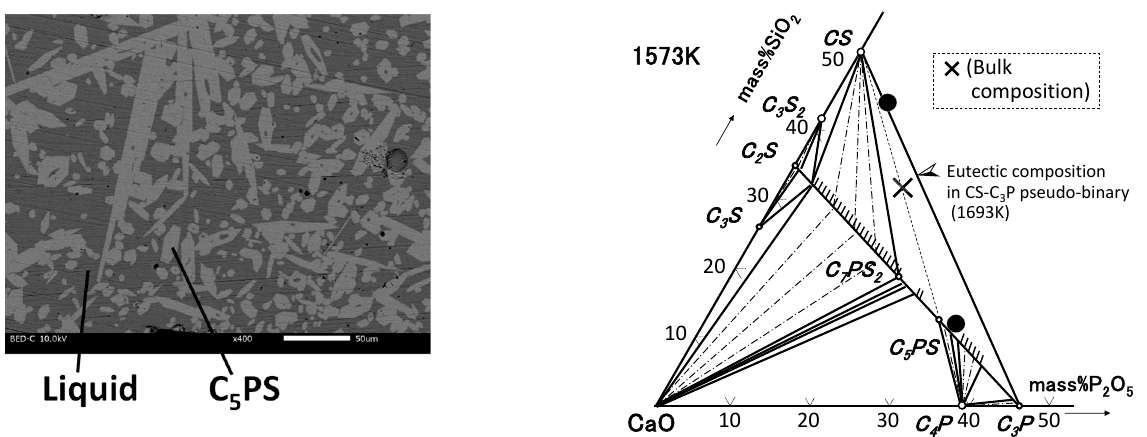
Figure 8. SEM image of M3-A10 (10mass% Al 2 O 3 ) ( left ) and the phase composition projected on an isothermal section of the CaO-SiO 2 -P 2 O 5 ternary phase diagram at 1573 K ( right ). Table 4. Compositional analysis of the observed phases in the quaternary samples containing Al 2 O 3 (in mass%).